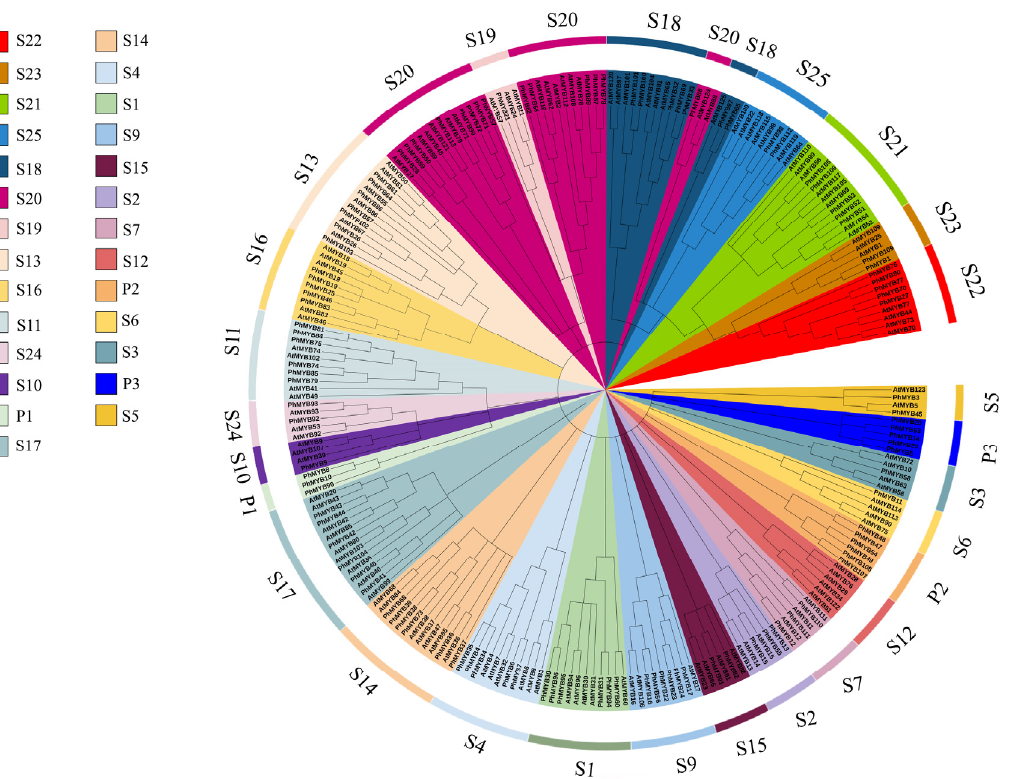
Figure 1. Phylogenetic tree of 113 R2R3-MYB members in petunia and 126 R2R3-MYB members in Arabidopsis. Petunia R2R3-MYB proteins were assigned to 28 distinct subgroups (S1–S25, P1–P3) based on the classification of Arabidopsis. The 28 subgroups were highlighted with different colors.